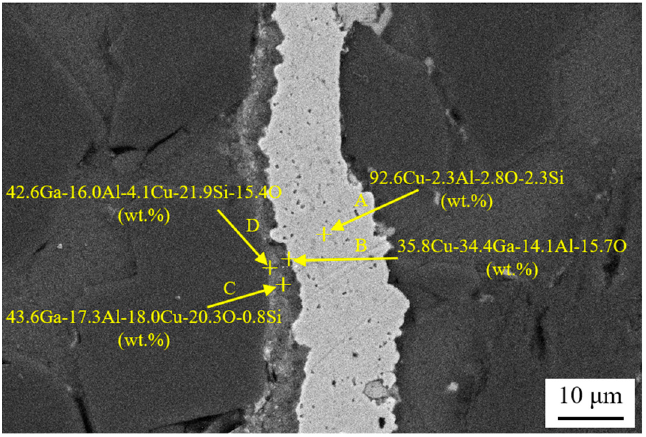
Figure 6. Energy dispersive X-ray spectroscopy (EDS) analysis of the joint made using liquid gallium with nano-copper particles at 450 °C.